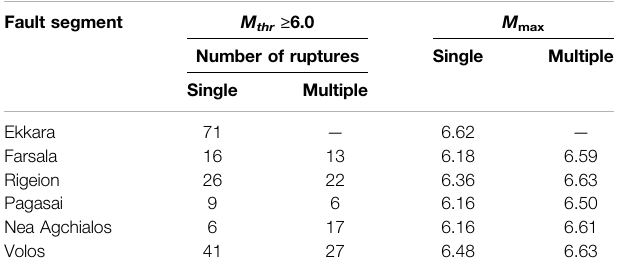
TABLE 4 | Summary of single and multiple ruptures for the M thr ≥ 6.0 for each of the six segments of the Southern Thessaly Fault Zone along with